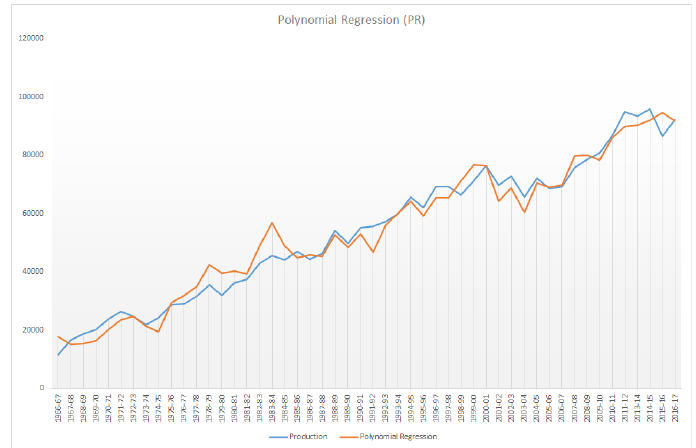
Figure 5: Forecasting using Polynomial Regression